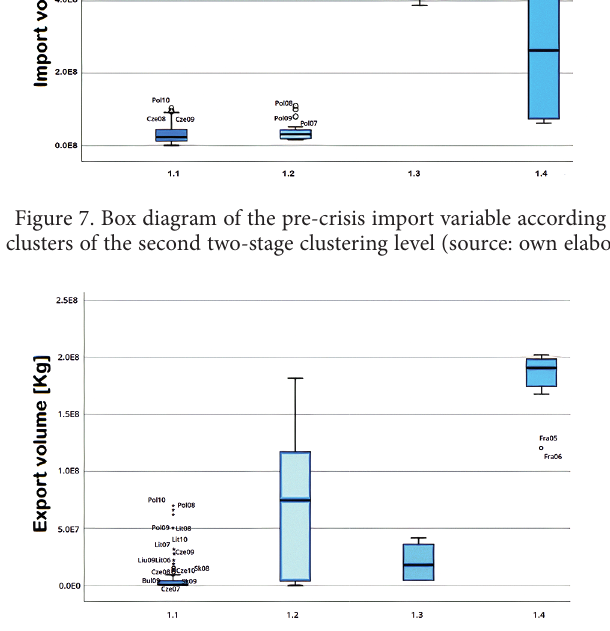
Figure 8. Box diagram of the pre-crisis export variable according to the clusters of the second two-stage clustering level (source: own